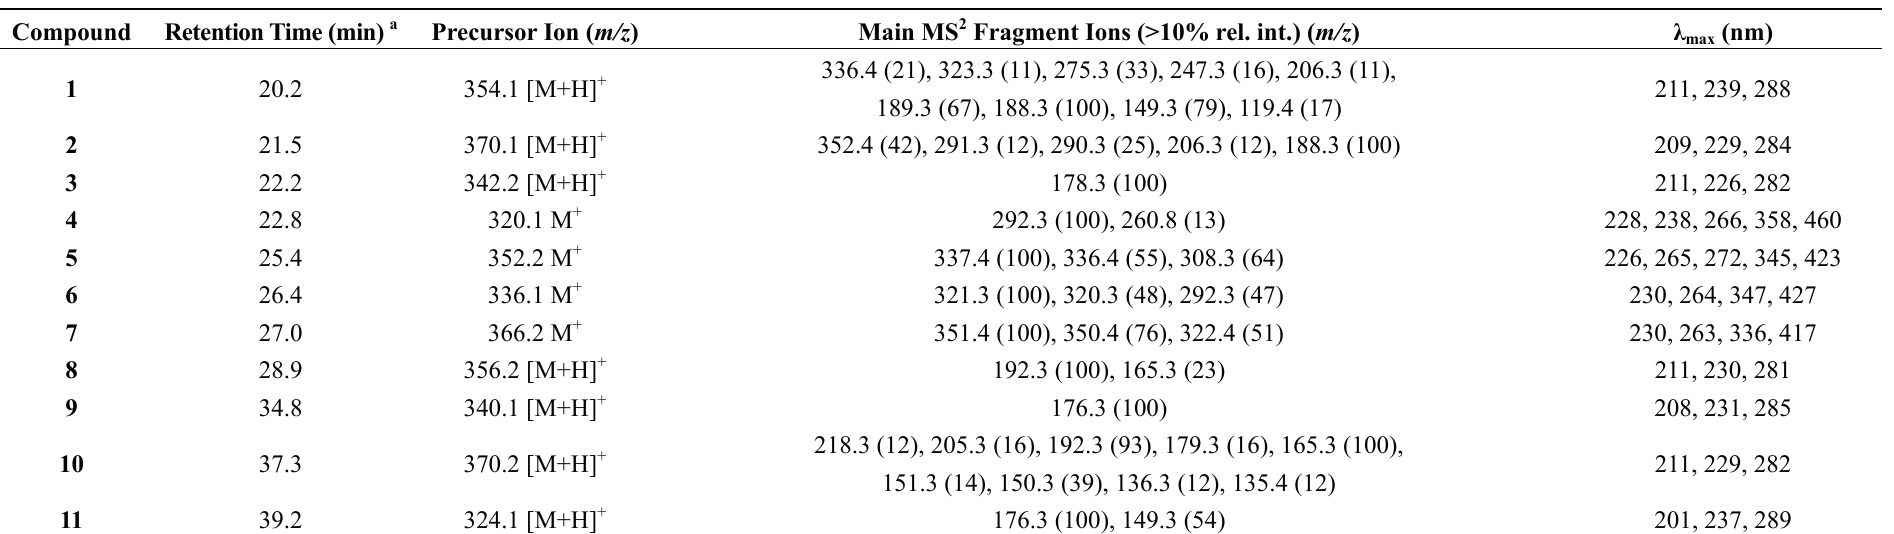
Table 1. HPLC-DAD and LC-MS data for alkaloids of Corydalis Rhizoma.